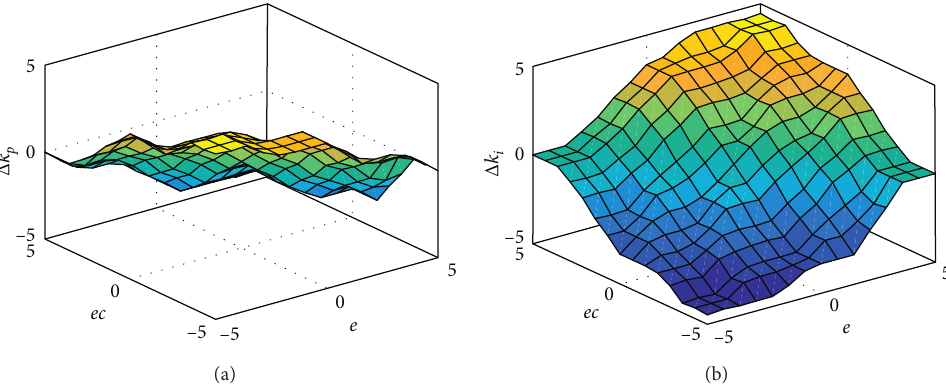
Figure 5: Fuzzy input and output rule surface. (a) Input and output Δ K